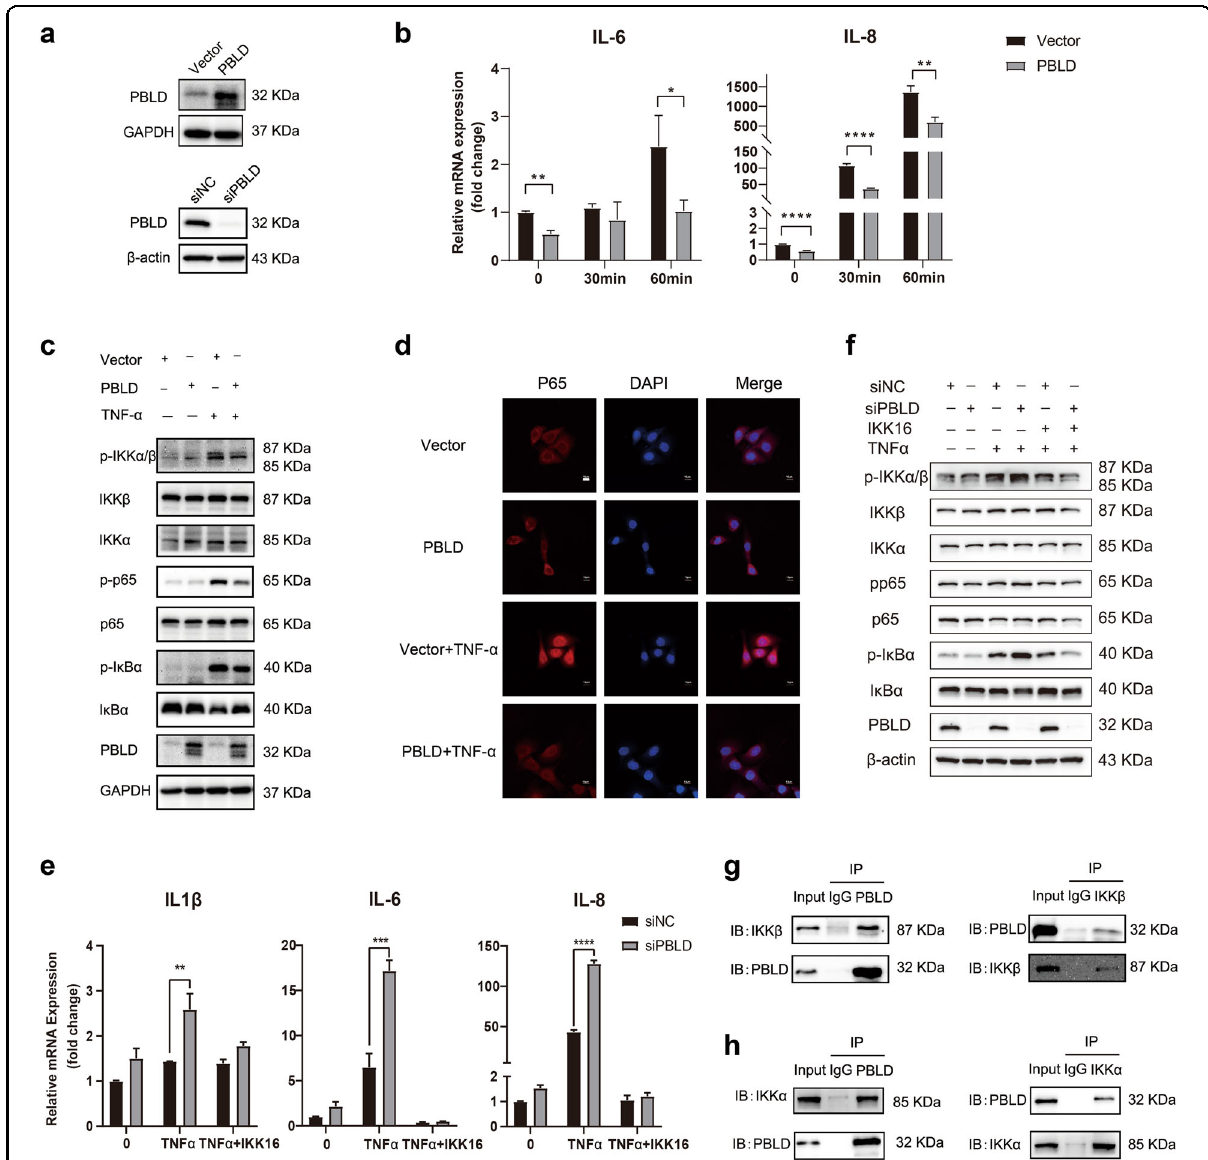
Fig. 7 PBLD suppresses TNF- α -induced in fl ammatory responses in IECs by inhibiting NF- κ B activation. a Western blot showing the expression of PBLD in a fetal human cell line (FHC) transfected with PBLD-expressing lentivirus (FHC-PBLD) or control lentivirus vector (FHC-vector) (upper) and siNC or siPBLD (lower). b qRT-PCR results showing the production of in fl ammatory mediators in FHC-vector and FHC-PBLD after TNF- α (10 ng/mL) treatment for the indicated amount of time. Data are mean±standard deviation (SD). ** p < 0.01. c Western blot analysis of proteins in FHC-vector and FHC-PBLD cells after TNF- α (10 ng/mL) treatment for 1 hour. d Immuno fl uorescent staining for p65 in FHC-vector and FHC-PBLD cells after TNF- α (10 ng/mL) treatment for 1 hour. Scale bars: 10 μ m. e qRT-PCR analysis of in fl ammatory mediators production and ( f ) immunoblot analysis of NF- κ B signal pathway in FHC cells transfected with siNC or siPBLD, treated with 5 µM IKK-16 for 2 hours, followed by TNF- α (10 ng/mL) treatment for 1 h. g Immunoblot analysis of IKK β and PBLD expression in a co-immunoprecipitation assay with anti-PBLD (left) or anti-IKK β (right) antibodies in FHC- PBLD cells. h Immunoblot analysis of IKK α and PBLD expression in a co-immunoprecipitation assay with anti-PBLD (left) or anti-IKK α (right) antibodies in FHC-PBLD